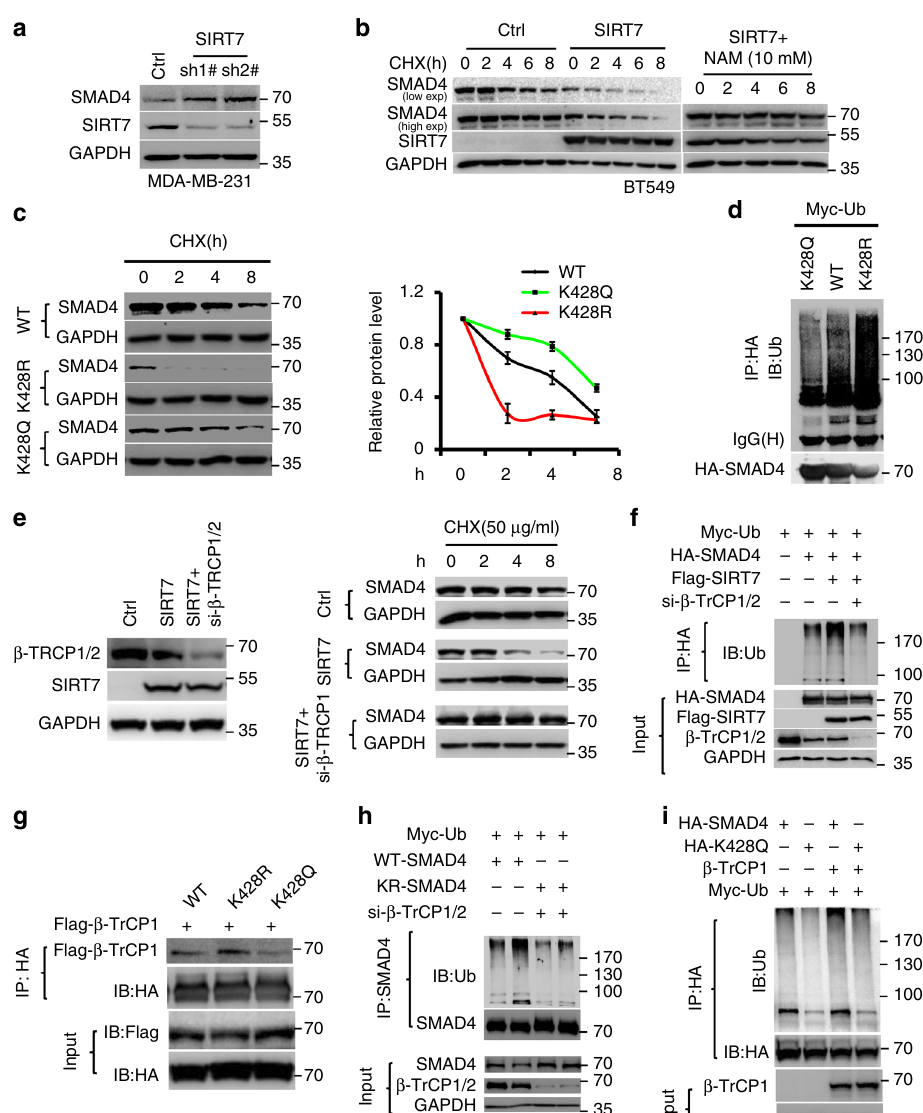
Fig. 6 SIRT7 promotes β -TrCP1-mediated SMAD4 degradation. a Immunoblots showing SMAD4 protein levels in Scramble (Ctrl) or shSIRT7-treated MDA-MB-231 cells. b Immunoblots showing SMAD4 levels in the presence of CHX, with or without ectopic SIRT7 or NAM. c Wild-type, K428R, and K428Q mutants of SMAD4 levels in the presence of CHX (50 μ g/ml). Quanti fi cation was performed by Image J; data were presented as mean ± S.D. d Ubiquitination levels of SMAD4 WT and mutants. e Immunoblots showing SMAD4 level in cells expressing ectopic SIRT7, treated with control or β -TrCP1 siRNA. f Immunoblots showing polyubiquitination of SMAD4 in the presence or absence of ectopic SIRT7 or β -TrCP1 siRNA. g Immunoprecipitation showing the binding capacity between Flag- β -TrCP1 and various HA-SMAD4 mutants. h , i Ubiquitination levels of HA-SMAD4 K428R h and K428Q i in cells treated with control or β -TrCP1 siRNAs or ectopic β -TrCP1 as